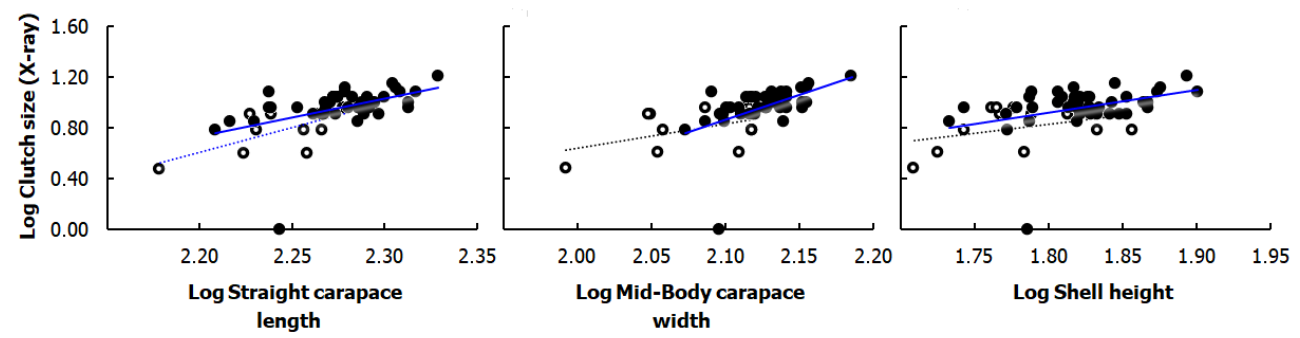
Figure 4. Linear regressions based on log-transformed data between selected body size measure- ments and clutch size obtained by X-ray in Mauremys leprosa from studied populations. Data from the Boukhmira population (the solid trendlines associated with the black circles) and the Lake Tonga population (the dotted trendlines associated with the open circles) were analyzed separately. Equations of significant regression lines (blue lines) are from the top left respectively: Log Clutch size = − 5.86 + 3.00 Log SCL (R-Sq = 21.2%); Log Clutch size = − 7.93 + 3.89 Log SCL (R-Sq = 49.1%); Log Clutch size = − 7.45 + 3.96 Log MCW (R-Sq = 26.4%); Log Clutch size = − 2.28 + 1.78 Log SH (R-Sq =